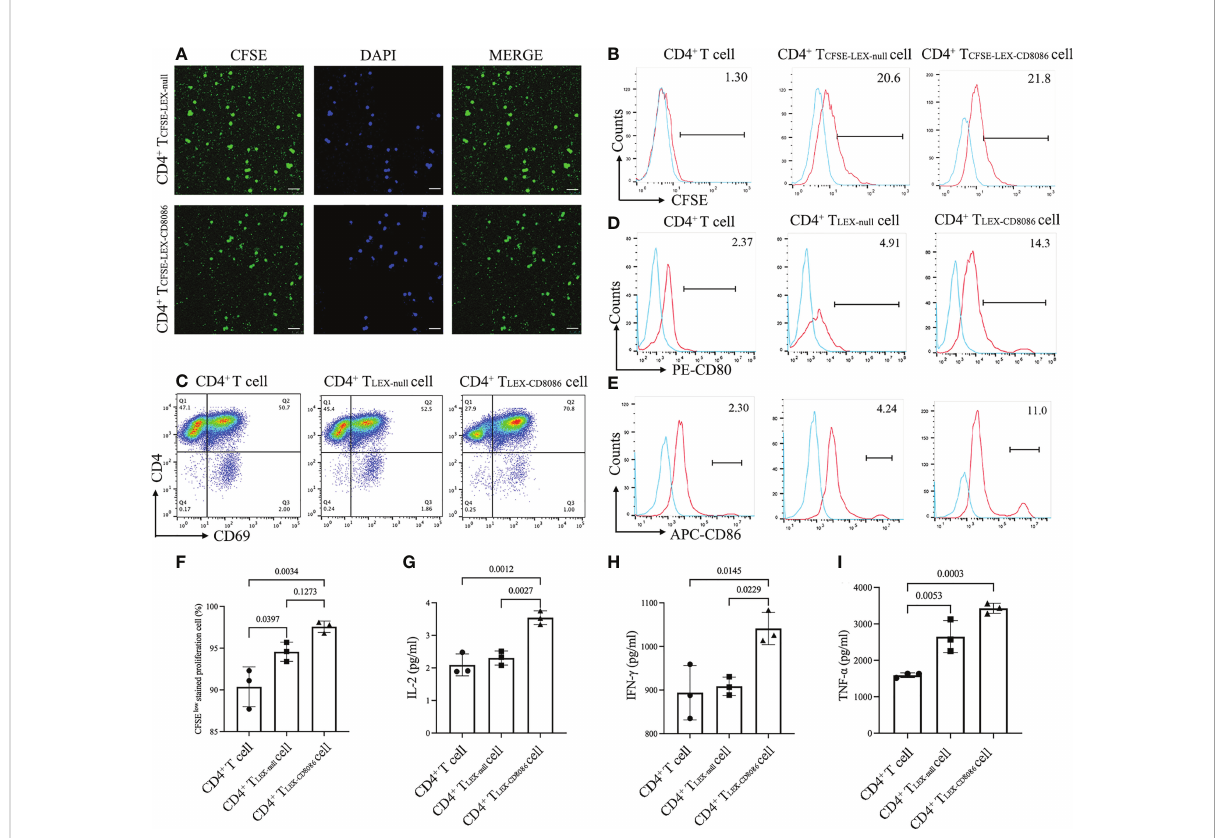
FIGURE 3 LEX-CD8086 uptake by CD4 + T cells and the effects of LEX-CD8086 on CD4 + T cell proliferation and cytokine assay. (A) Fluorescence microscope analysis of mouse splenic CD4 + T cells (stimulated with anti-CD3/CD28 antibodies) after incubation with CFSE-labeled L1210- CD8086 or L1210-null cell-derived exosomes for 6 h. bar scale = 20 m m. (B) Flow cytometric analysis of the cellular uptake of mouse splenic CD4 + T cells after incubation with CFSE-labeled L1210-CD8086 or L1210-null cell-derived exosomes for 6 h. (C – E) Analysis of CD69, CD80 and CD86 expression on CD4 + T cells after co-cultured with LEX-CD8086. (F) The proportion of CFSE Low stained CD4 + T cells after incubation with LEX-CD8086 by fl ow cytometry and quantitative analysis of the results of CFSE Low stained CD4 + T cells. Secretion of IL-2 (G) , IFN- g (H) , and TNF- a (I) in the supernatants of CD4 + T cells cocultured with LEX-CD8086. All the results shown above represent at least three independent experiments. Data are mean ± SD of three independent biological replicates. P values are from